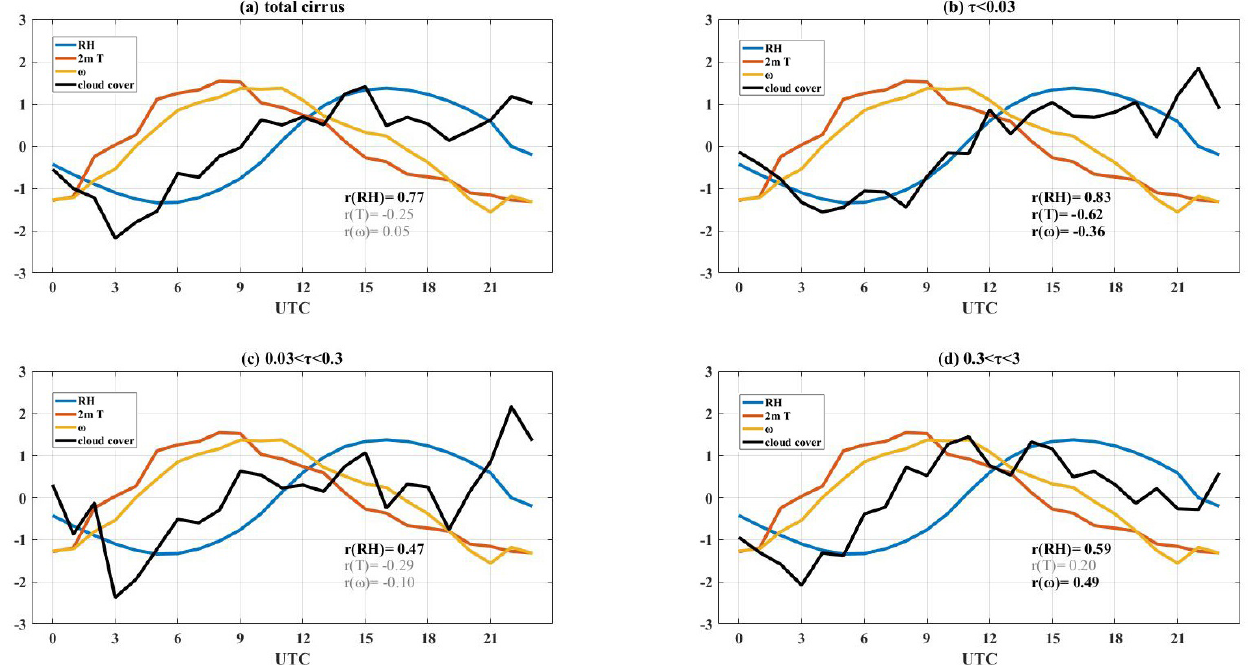
Figure 9. The standardized cloud cover of different types of cirrus (black lines), 250hPa relative humidity (%) (blue lines), 2m temperature (K) (red lines), and 250hPa vertical velocity (Pas − 1 ) (yellow lines) over the TP: (a) all cirrus, (b) subvisible cirrus (optical thickness less than 0.03), (c) thin cirrus (optical thickness between 0.03 and 0.3), (d) opaque cirrus (optical thickness between 0.3 and 3). The correlation coefficients are indicated in the bottom-right corner. Correlation coefficients in bold indicate that it can pass the 90% significance